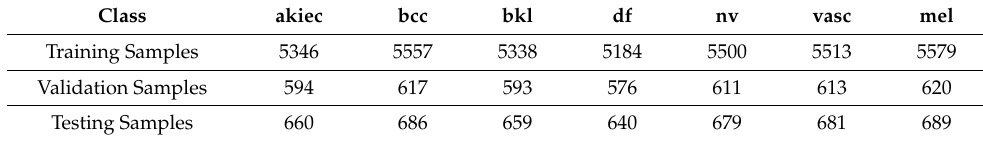
Table 11. Class-wise images present in HAM10000 dataset with protocol-III.